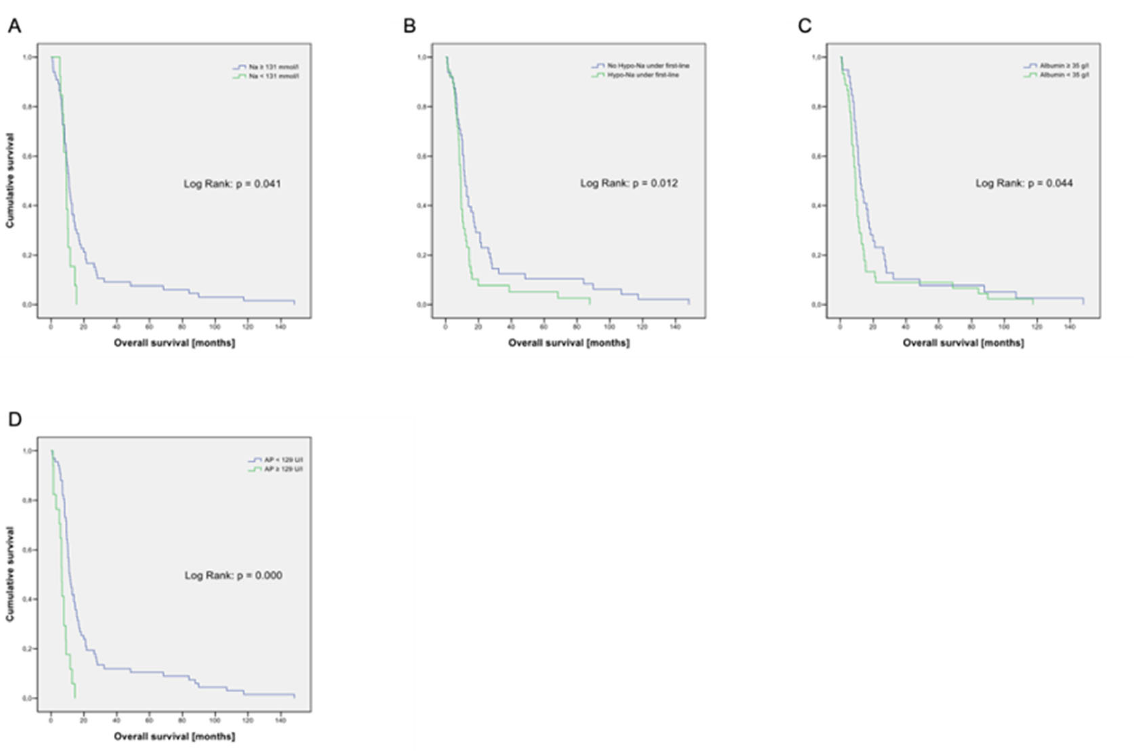
Figure 2. ( A ) Kaplan–Meier graph for overall survival according to sodium level. N = 79. Na =